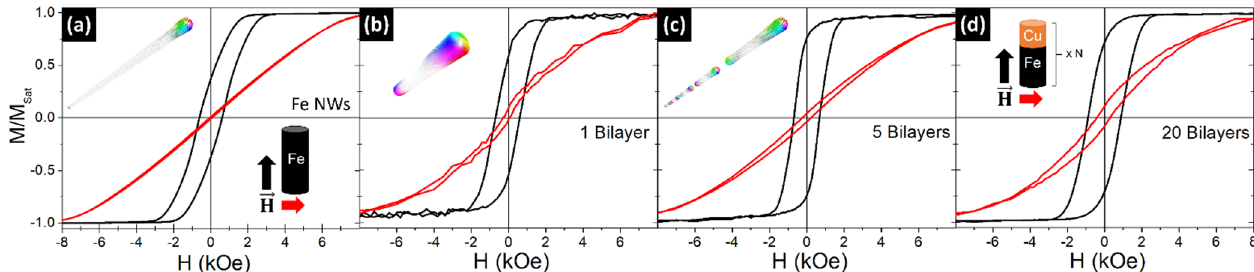
Figure 3. Magnetic hysteresis loops of ( a ) Fe NW arrays with 45 nm in diameter and 3000 nm in length and ( b – d ) Fe/Cu NW arrays with 45 nm in diameter, Fe lengths of ~300 nm, Cu segment lengths of ~120 nm, and ( b ) 1, ( c ) 5, and ( d ) 20 bilayers, measured along the parallel (black) and perpendicular (red) directions. Insets show the respective 3D simulated magnetic configurations at the switching field state, when applying the magnetic field parallel to the wire